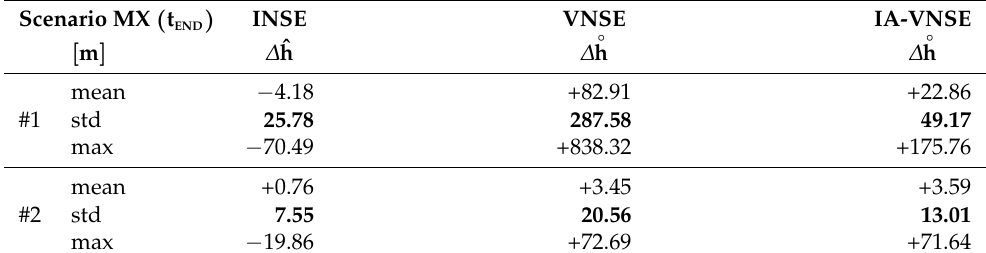
Table 5. Aggregated MX final vertical position INSE, VNSE, and IA-VNSE (100 runs). The most important metrics appear in bold.